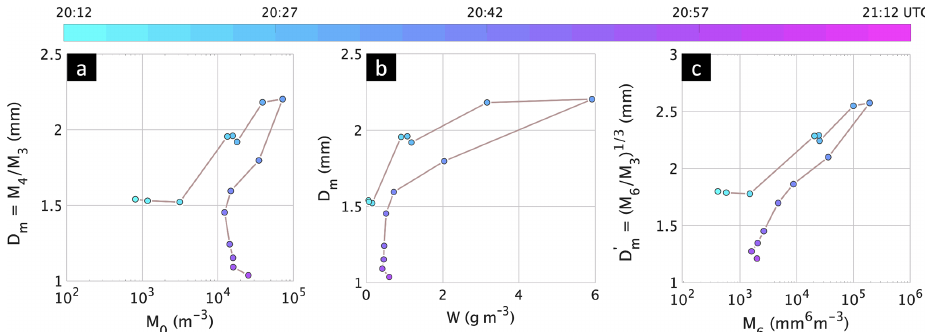
Figure 13. Time tracks of radar-derived variables in the (a) D m versus M 0 plane showing the trajectories as a function of time (color coded) over approximately an hour. Each data point reflects the radar-retrieved moments ( M 0 ) or ratio of moments ( M 4 /M 3 ) (see Fig. 9). (b) – (c) Same but time tracks in the D m versus W plane and D (cid:48) m versus M 6 planes, respectively. Again, all quantities are from radar-retrieved